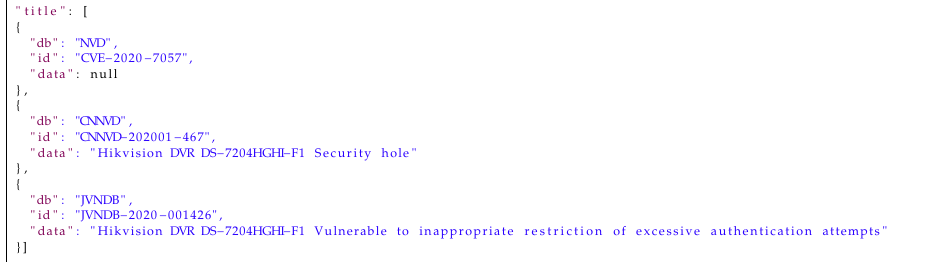
Listing 3. Example of the title field from the medium database